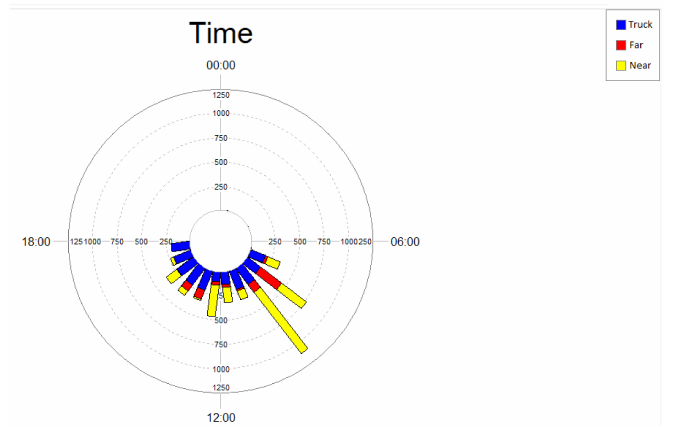
Figure 3. Temporal distribution of phee -type calls of black-tufted marmosets ( Callithrix penicillata ) in the area near (yellow) and the area far (red) from the Brucutu Mine, and number of noise events generated by the truck passes detected on the road near the mine (blue), Peti reserve, Minas Gerais,